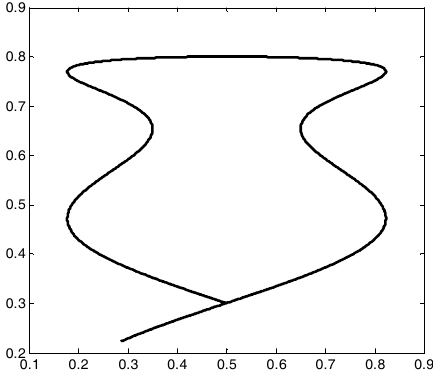
Figure 13. Extension to left of the reference.